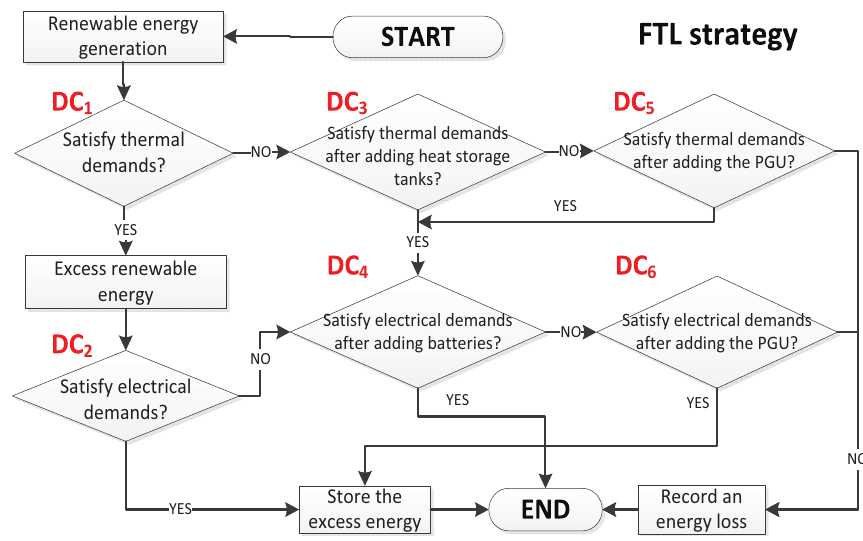
Figure 6. Flowchart of the following thermal load (FTL) operation strategy.